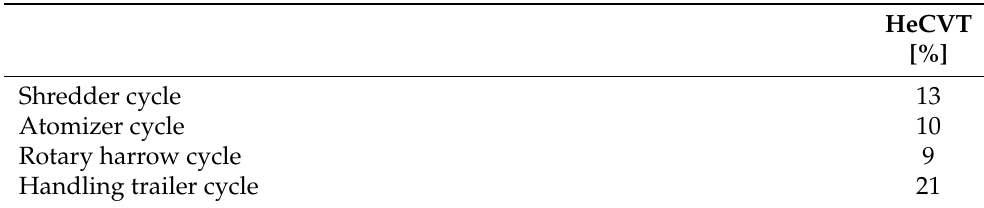
Table 8. Diesel fuel saving of the HeCVT architecture in the proposed 8 h work cycles compared to conventional diesel tractor